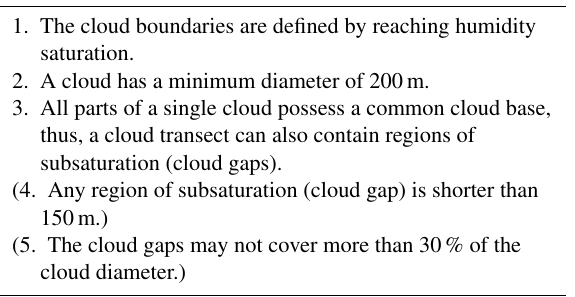
Table 3. Criteria for identifying the cloud. The stricter cloud re- quirements, 4 and 5, are optional and used in a repetition of the analysis in order to test the sensitivity of the